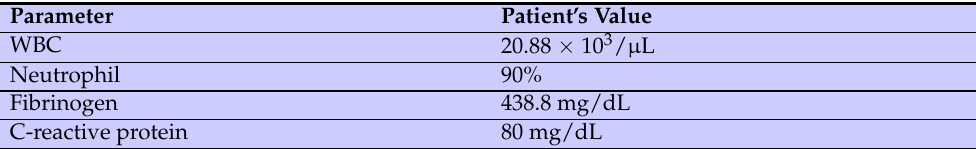
Table 2. Patient’s value of re-evaluation(decrease of inflammatory